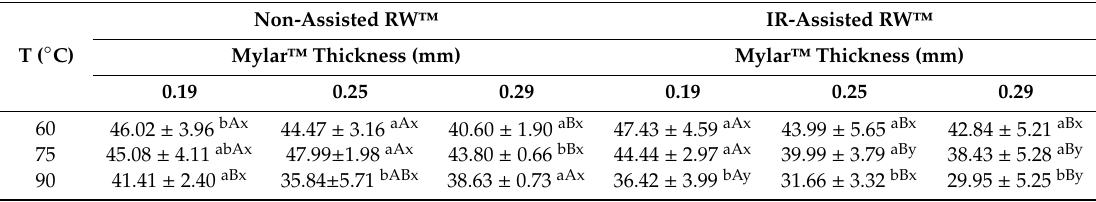
Table 5. Changes in L* coordinate values of dried Physalis pur é e subjected to di ff erent RW ™ drying